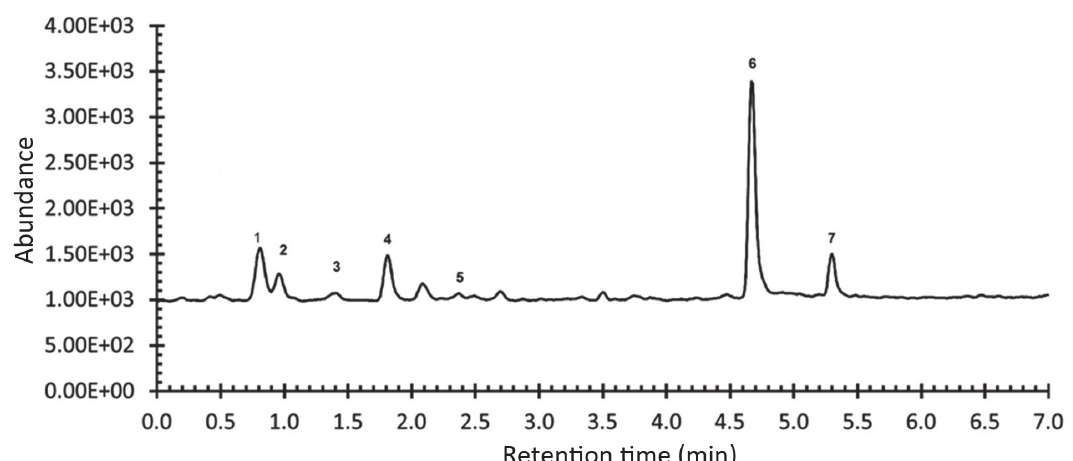
FIGURE 1 - UHPLC/MS chromatogram of V. litoralis crude extract: 1-chlorogenic acid; 2-vanillic acid; 3-caffeic acid; 4- p -coumaric acid; 5-ferulic acid; 6-luteolin;